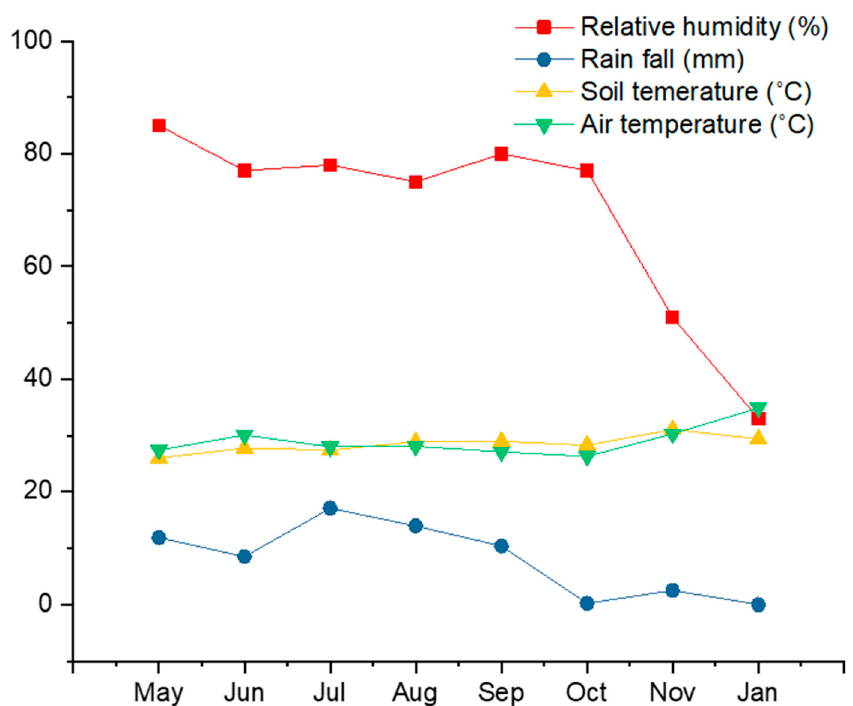
Figure 6. Average air and soil temperature, precipitation (rain fall), and relative humidity during the study period. Air temperature, relative humidity, and soil temperature were measured in all 25 plots every month from May 2004 to January 2005 (see experimental set up section). Rainfall was measured with a standard cylindrical rain gauge located nearby the experimental area (~1 km) at Srinakharinwirot University Research Station at Na Haeo.